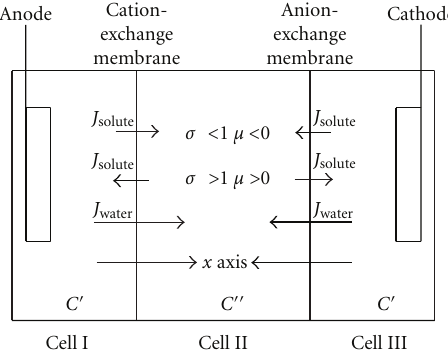
Figure 15: Electrodialysis